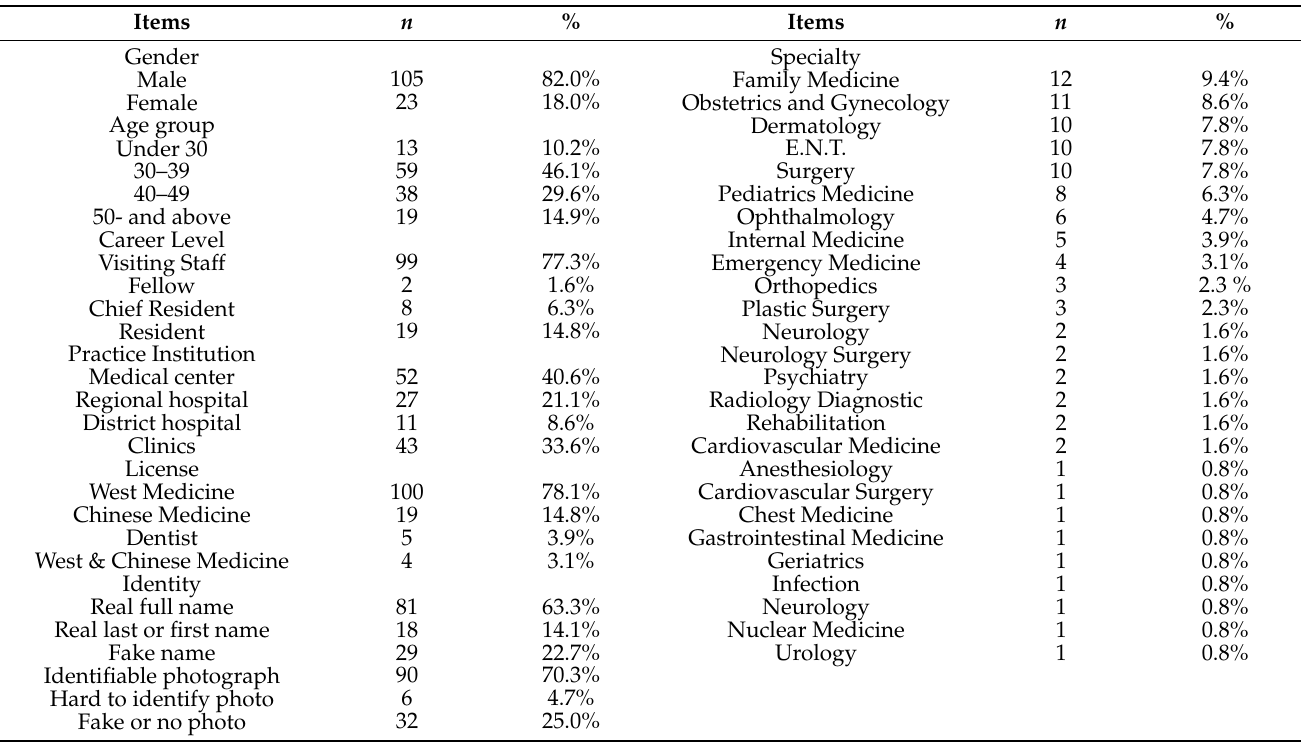
Table 1. The Demographic Description of